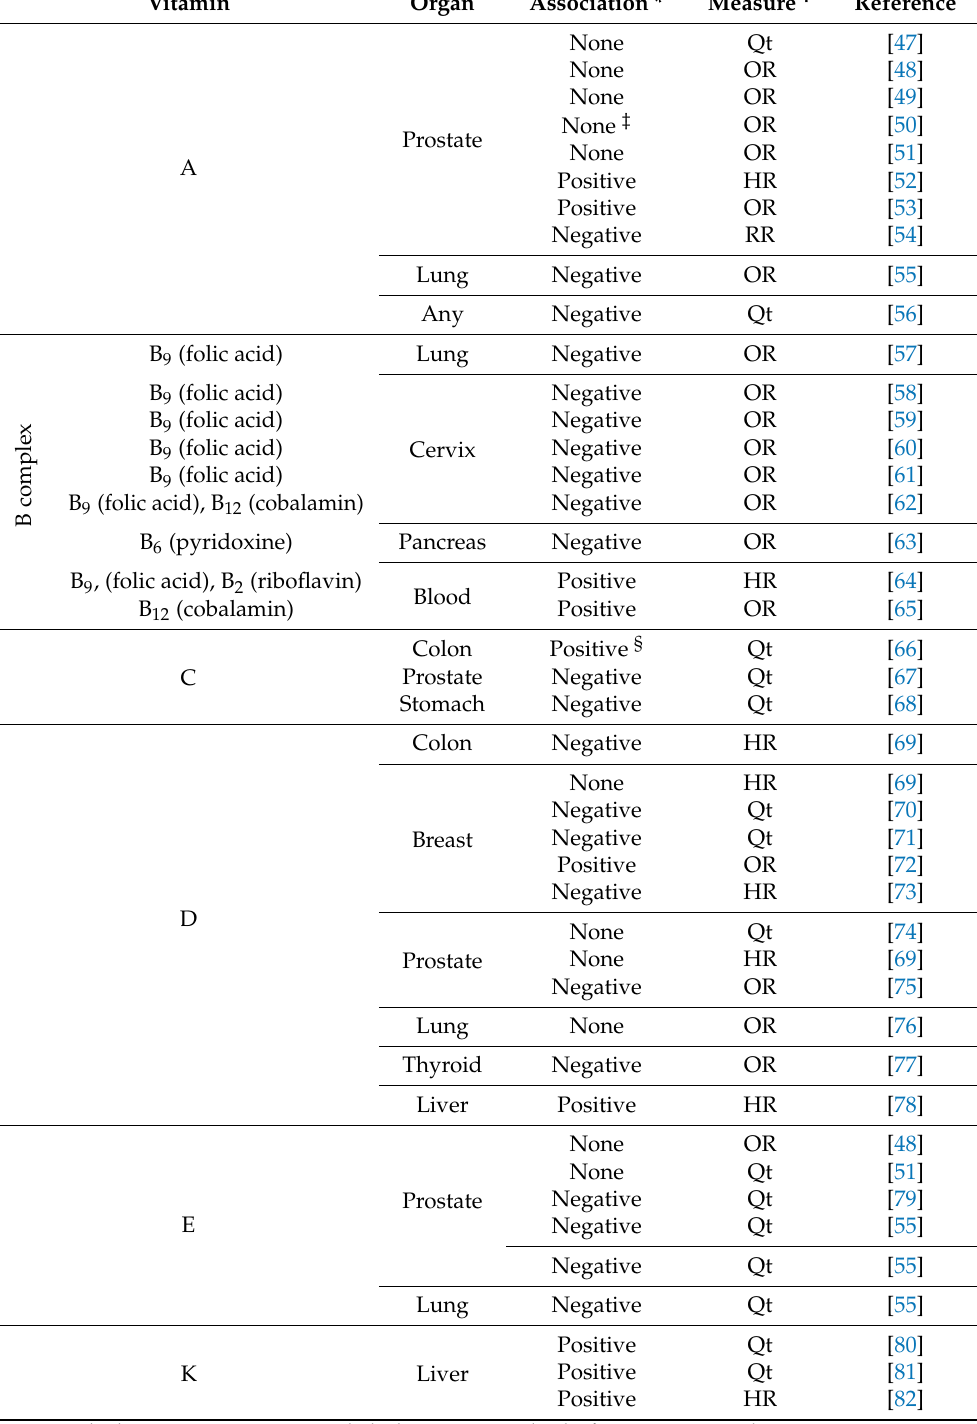
Table 2. Summary of the association between vitamins and risk of